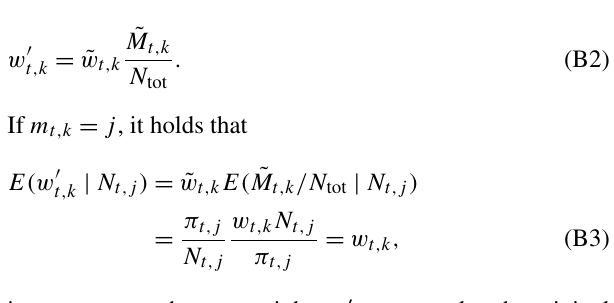
The Cryosphere, 15, 5017–5040,